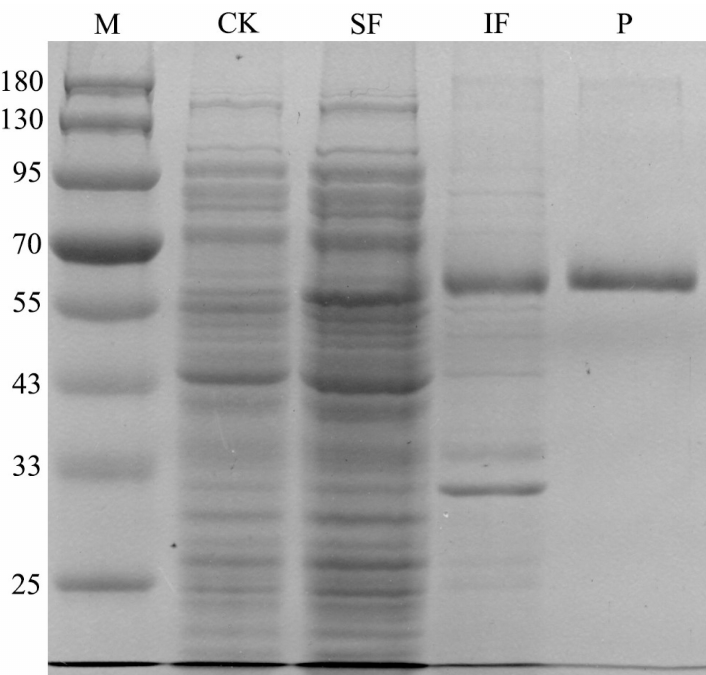
Figure 6. Expression and purification of MO5660. Samples were subjected to 10% SDS-PAGE followed by Coomassie Blue staining. M: Trelief™ Prestained Protein Ladder (Tsingke Biotech Co.,